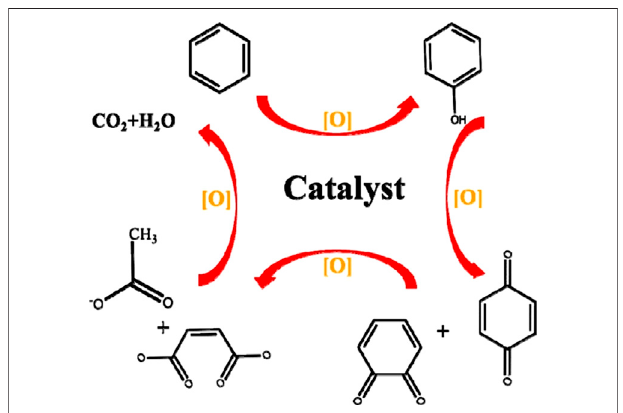
FIGURE 1 | Proposed mechanism of benzene oxidation over the TiO 2 / PdW-S catalyst. Reprinted with permission from ref 151. Copyright (2019) American Chemical